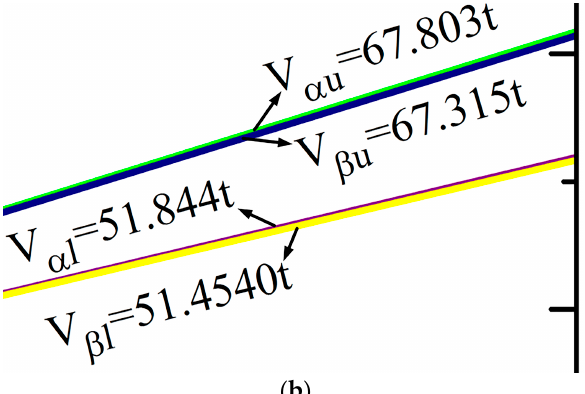
Figure 14. ( a ) The relationship between angular velocity and time in different states; ( b ) the partial enlarged detail in the dash dot frame. Table 14. The comparison of moment of inertia between experimental and theoretical results.